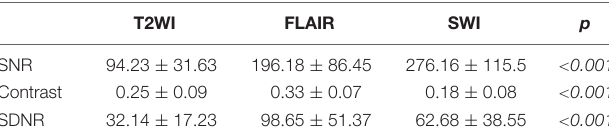
TABLE 3 | SNR, contrast, and SDNR for subthalamic nucleus in 45 patients with medication-refractory Parkinson’s disease. T2WI FLAIR